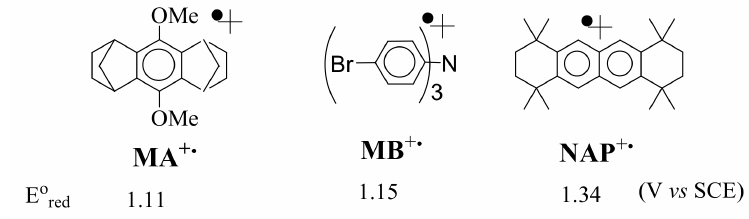
Figure 3. Stable aromatic radical